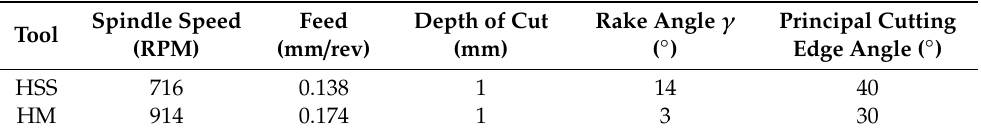
Table 2. Metal-cutting